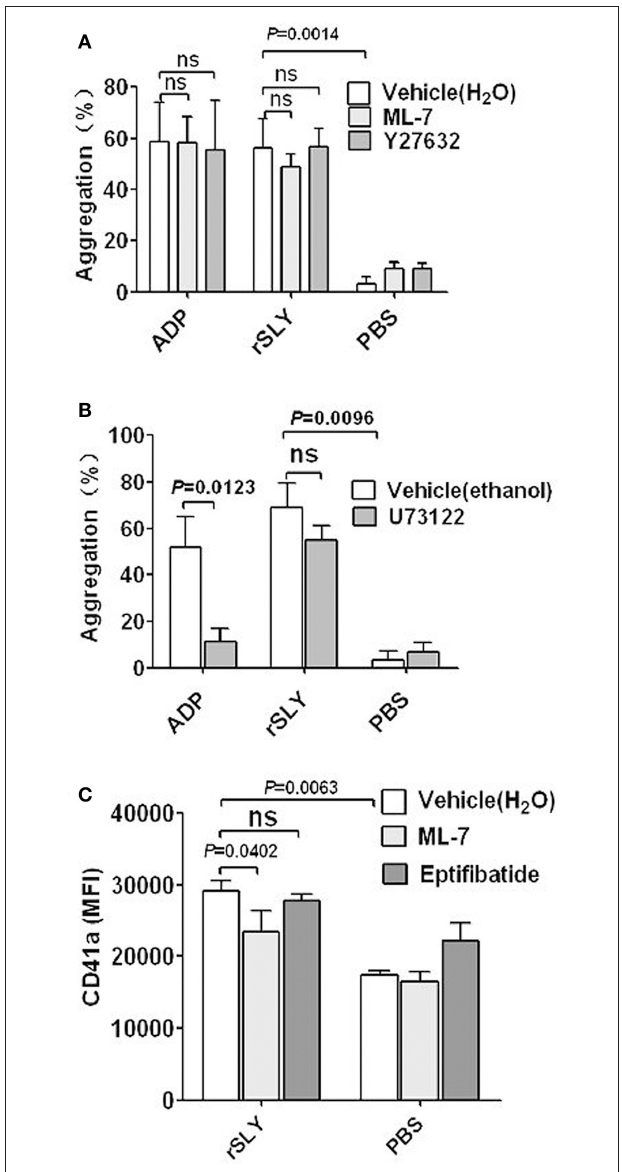
FIGURE 5 | Platelet signaling in response to SLY. (A,B) rSLY (1 µ g/mL)-induced platelet aggregation in PRP pretreated with or without